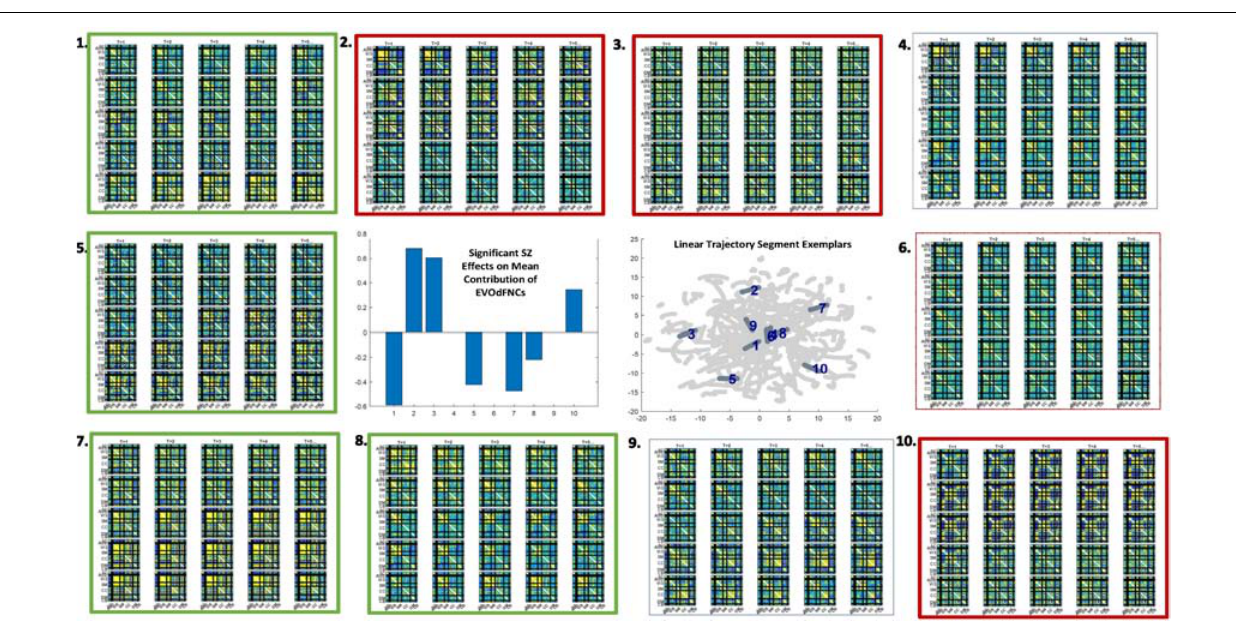
FIGURE 11 | There are pervasive group differences between schizophrenia patients and controls in representational importance of the K = 10 EVOdFNCs; thick red (respectively, thick green) boxes designate significant positive (respectively, negative) association with SZ after correction for multiple comparisons; thin dashed red box designates significant ( p < 0 . 025) positive association with SZ that is not significant after correction for multiple comparisons. Omitted colorbar is bounded by [− 0 . 3 , 0 . 3 ]